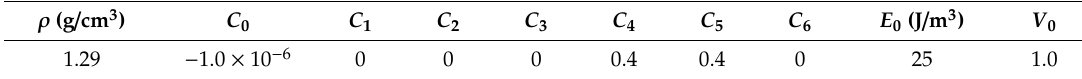
Table 3. Parameters of the air.